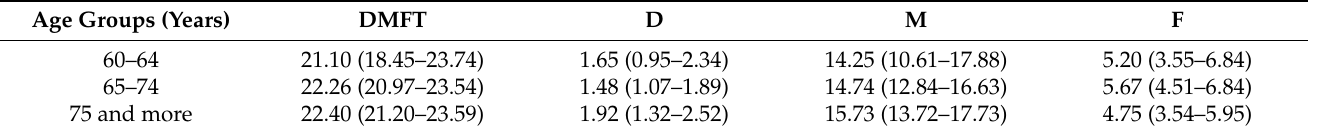
Table 2. Mean DMFT index and its components (95% confidence interval in